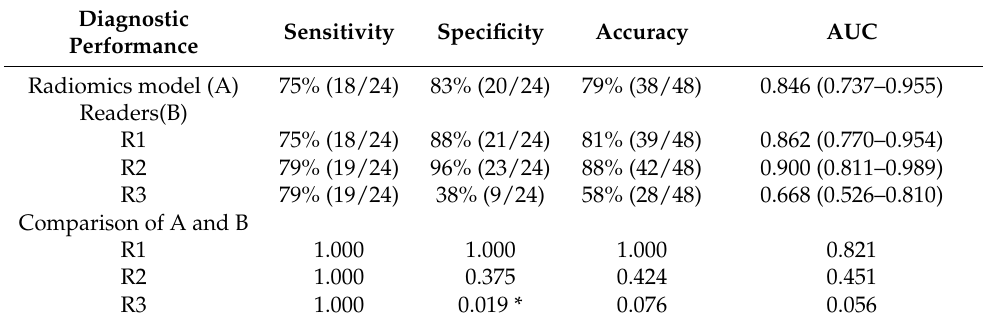
Table 3. Comparison of diagnostic performance of radiomics model and radiologists.